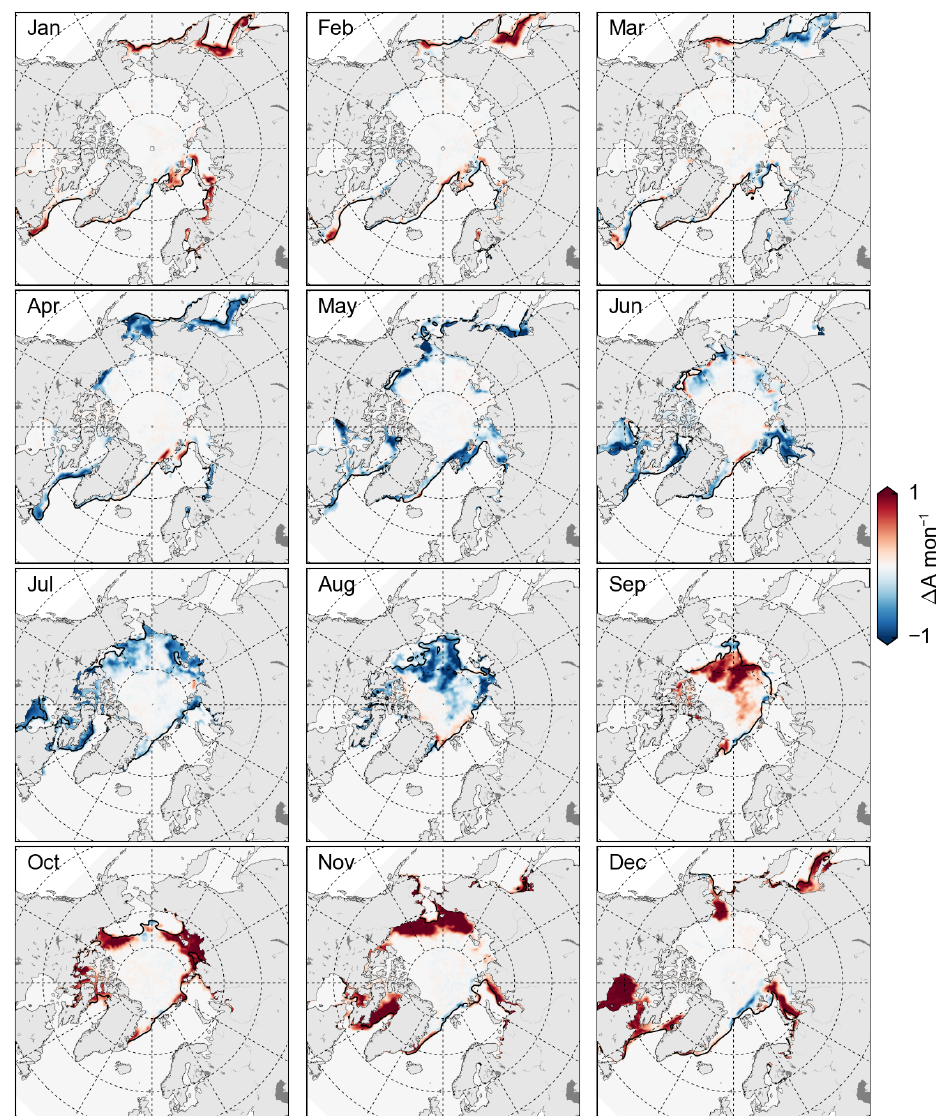
Figure 5. Monthly 2016 Arctic sea ice intensification estimates, calculated using the daily Bootstrap sea ice concentration data. Positive values (red) denote ice gain in a given grid cell. The units are concentration per month. The black contour indicates the monthly 2016 sea ice edge (0.15 ice concentration